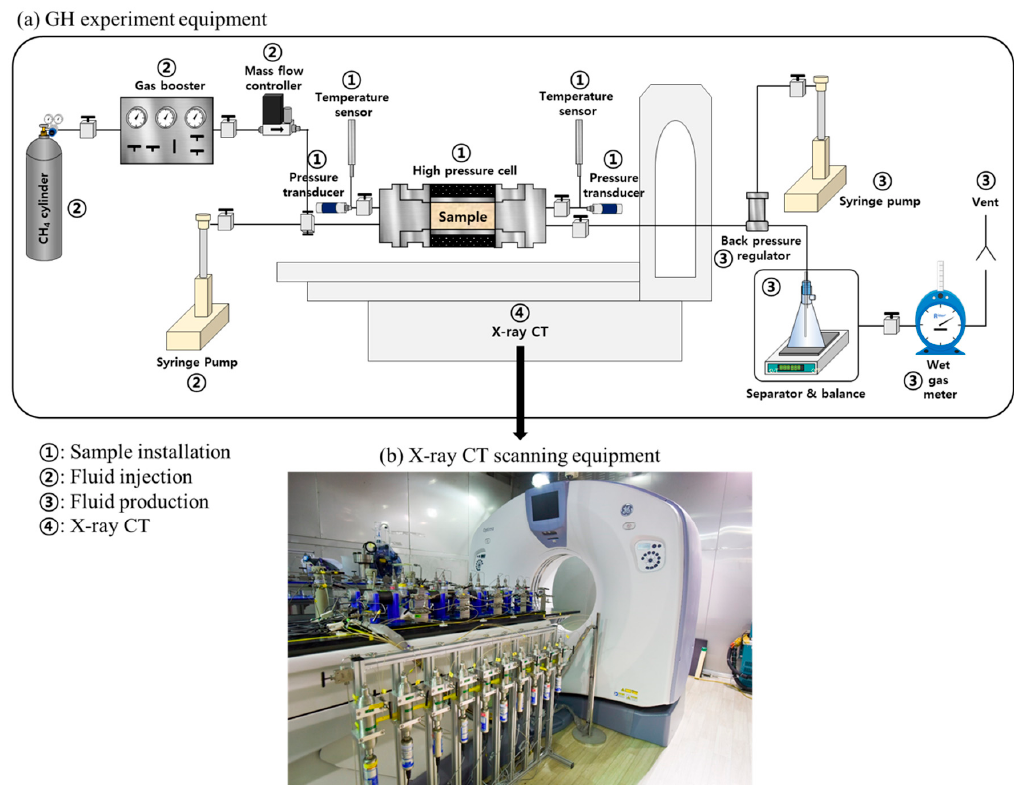
Figure 1. ( a ) Schematic diagram of the gas hydrate (GH) visualization system at Korea Institute of Geoscience and Mineral Resources (KIGAM) [31]; ( b ) the installed X-ray computerized tomography (CT) equipment for the system [31].